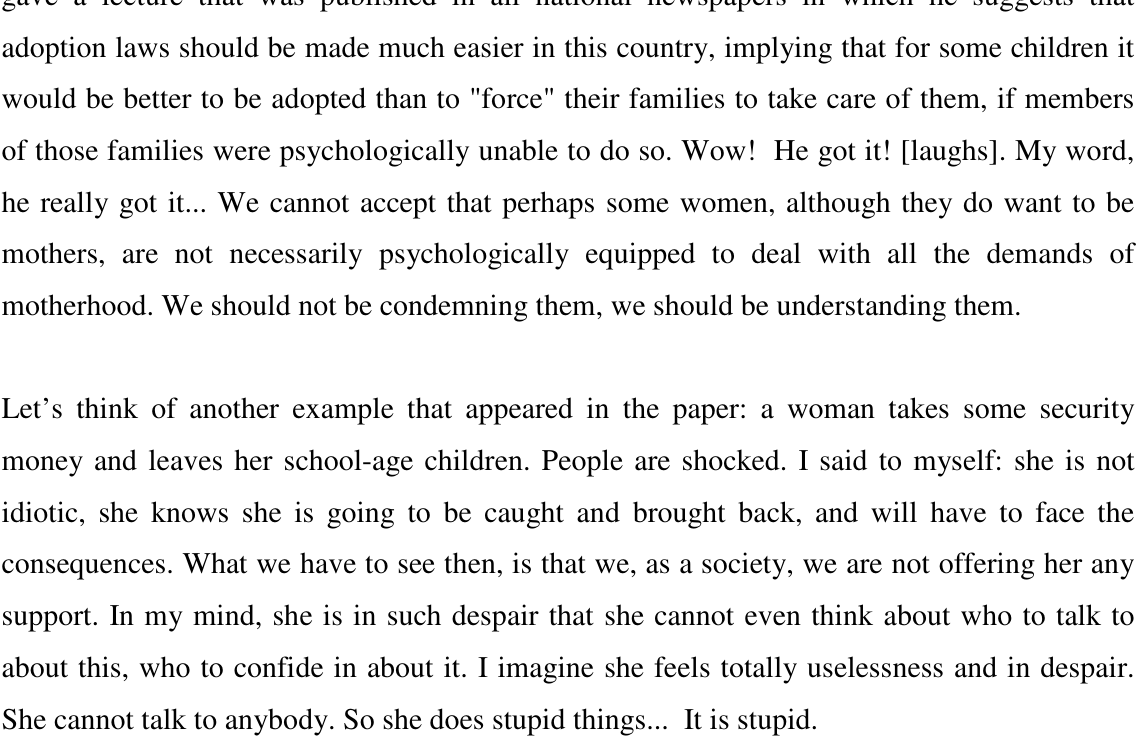
Estela Welldon in conversation with Sigal Spigel Introduction Sigal Spigel and Lisa